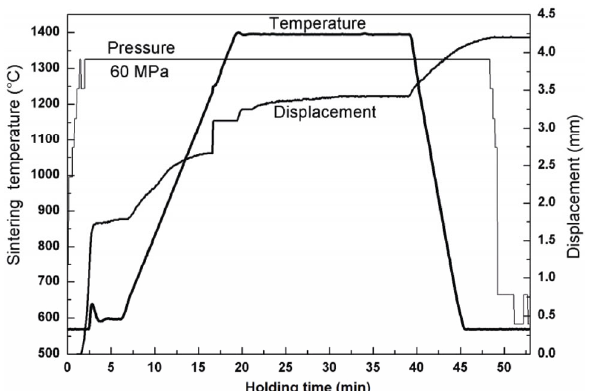
Variation of sintering temperature, sample shrinkage, and applied pressure during the SPS process